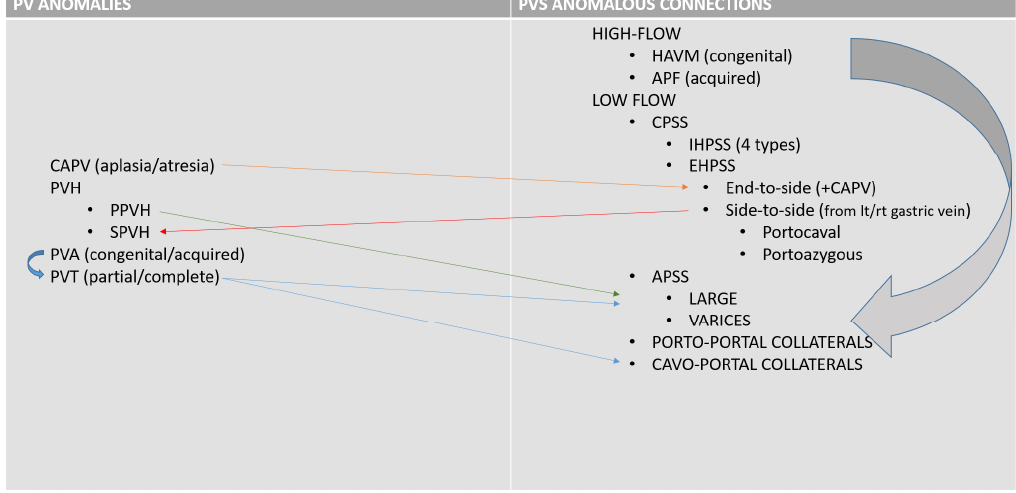
Figure 1. Schematization of the anomalies of the portal vein (left) and anomalous connections involving the portal venous system. Arrows indicate possible relationships between various congenital and acquired anomalies. CAPV, congenital absence of portal vein; PVH, portal vein hypoplasia; PPVh, primary portal vein hypoplasia; SPVH, secondary portal vein hypoplasia; PVA, portal vein aneurysm; PVT, portal vein thrombosis; HAVM, hepatic arteriovenous malformation; APF, arterioportal fistula; CPSS; congenital portosystemic shunt; IHPSS, intrahepatic portosystemic shunt; EHPSS, extrahepatic portosystemic shunt; APSS, acquired portosystemic